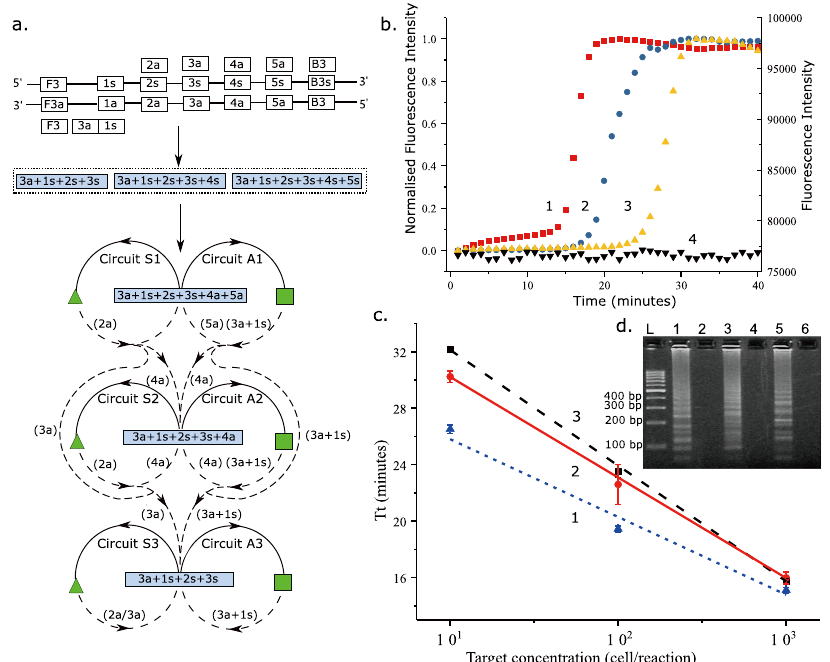
Fig. 5 Progressive model with exponential kinetics. a Reaction graph. Multiple primer extension arrows entering the same circuit, mediated by (3a + 1s + 2s + 3s, 3a + 1s + 2s + 3s + 4s, and 3a + 1s + 2s + 3s + 4s + 5s). b Real-time ampli fi cation curve of the progressive model with 10-time serially diluted target: 1. 400 M. tuberculosis cells (red square); 2. 40 M. tuberculosis cells (blue circle); 3. 4 M. tuberculosis cells (yellow up triangle); 4. Negative (black down triangle); 1 – 3 are normalised fl uorescence intensity ([0-1], left axis), whilst 4 is raw fl uorescence intensity (right axis). The samples were purchased extracted genomic DNA from a reference laboratory, characterised by digital PCR (see Methods). c System kinetics with different number of anti-sense primers examined by real-time ampli fi cation: 1. 3a + 4a + 5a (blue dot); 2. 3a + 4a (red solid); 3. 3a only (black dash). Threshold time (Tt) is the time corresponding to 20% of the maximum fl uorescence intensity in the reaction. Data are the average of three technical replicates and error bars show the standard deviation; d Agarose gel electrophoresis demonstrating the effect of different numbers of anti-sense primers added to the reaction. 1/2. 3a + 4a + 5a; 3/4. 3a + 4a; 5/6. 3a only. 1/3/5 were performed with 40 M. tuberculosis cells; 2/4/6 were negative. The gel is representative of experiments repeated independently three times with similar results. Supplementary Fig. S9 shows the secondary structure mechanism and the sequencing results of the product. Source data are provided as a Source Data fi which were used as targets in the further ampli fi cation process. complementary to a sequence that lies downstream on the same All pathways described here start with the addition of genomic strand of the target and anti-sense primers (2a, 3a, 4a and 5a) DNA. complementary to the individual sequences of the target, Fig. 5a. By programming this progressive model into the reaction In the corresponding molecular implementation, all the graph abstraction of Fig. 5a, we obtained an isothermal primers coexisted in the absence of target molecules. The target ampli fi cation system with a sense primer (3a + 1s) with the 3 ′ catalyses the generation of three different functional hairpin end complementary to the target sequence. The 5 ′ end was